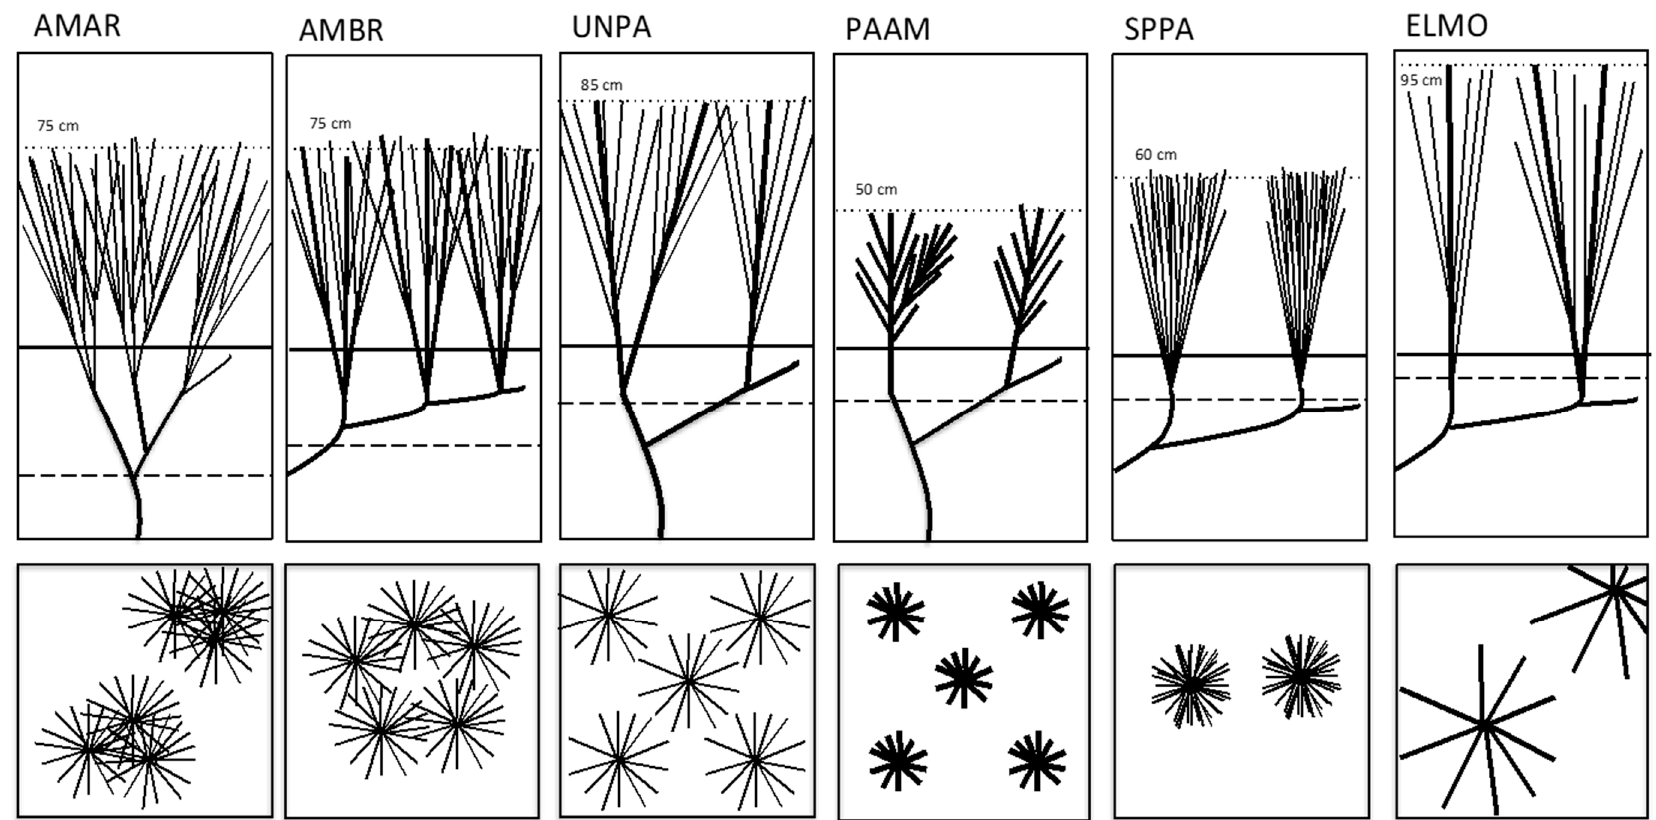
Figure 9. Diagram integrating growth form and morphological di ff erences, as well as hypothesized relative di ff erences in sand capture (represented by the distance from the solid line and the lower dashed line), among six species of dune grasses (AMAR = Ammophila arenaria , AMBR = Ammophila breviligulata , ELMO = Elymus mollis , PAAM = Panicum amarum , SPPA = Spartina patens , UNPA = Uniola paniculata ) from US East Coast and West Coast foredunes. The stippled line and value represent average plant height (from this study and Hacker et al. [11]). The lower boxes represent 0.25-m 2 quadrats.